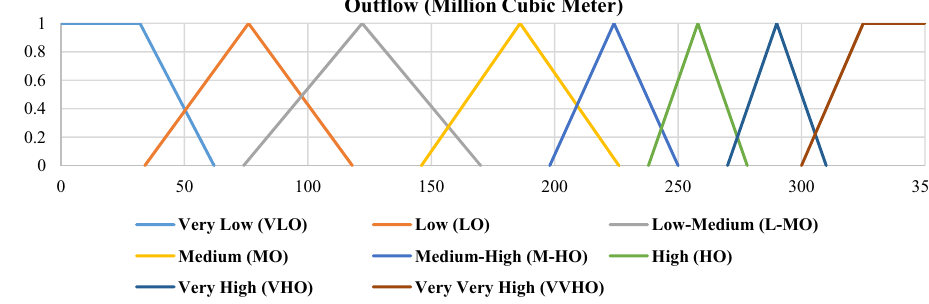
Fig. 4 Membership function for the universe outflow